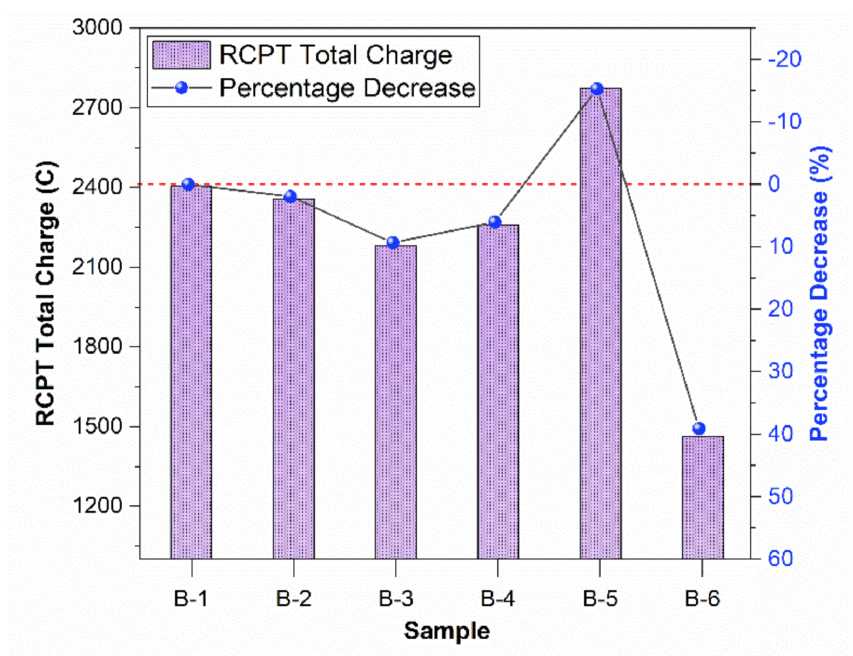
Figure 4. RCPT values of different concrete samples at 28